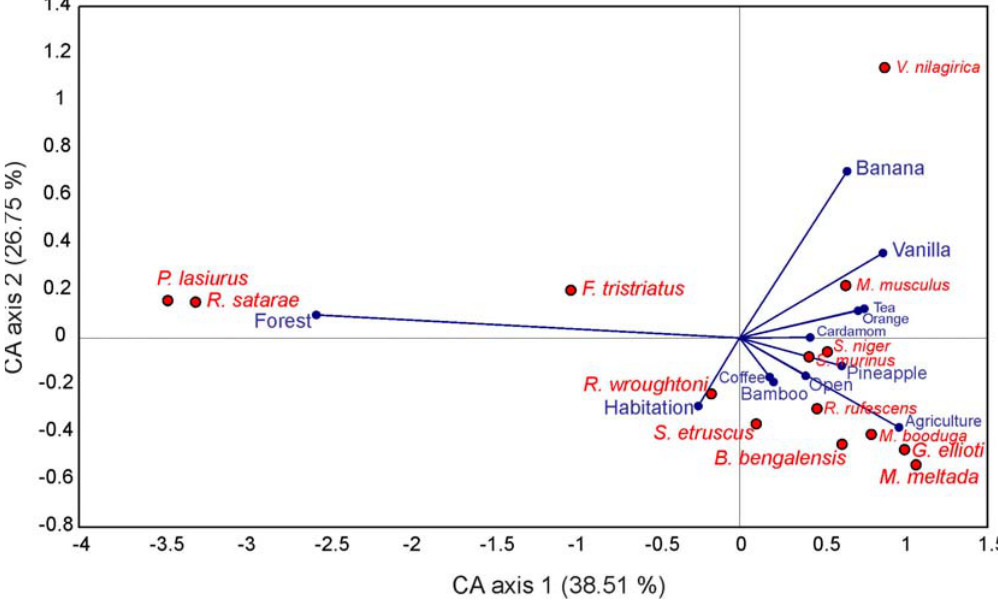
Figure 8. Correspondence Analysis of non-volant small mammals depicting the dependence of presence and abundance of species on habitat types. Numbers in parenthesis are percent variation explained by each correspondence axis. Factor loading for banana and V. nilagirica are divided by 10 before plotting to avoid scale